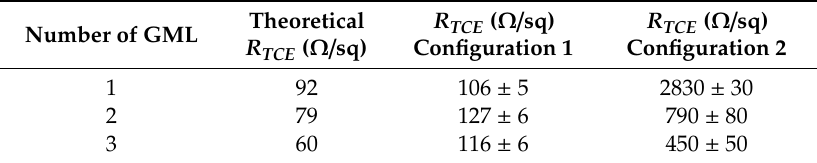
Table 1. Theoretical and measured sheet resistances of the TCEs as function of the number of GML and the configuration